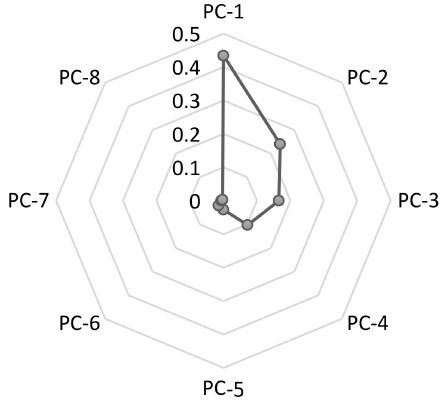
Figure 3. Covariance value of principal